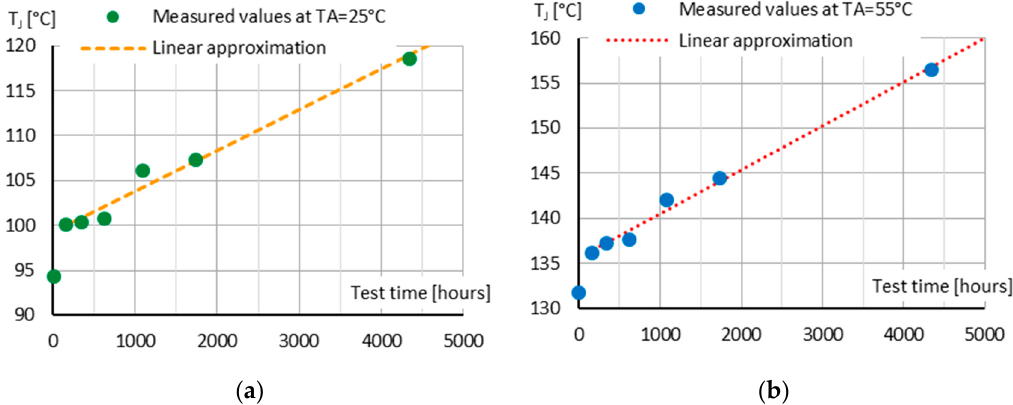
Figure 5. Pn-junction temperatures of the tested mid-power LED (#S11) over the testing time, measured at 300 mA forward current, ( a ) at 25 °C and ( b ) at 55 °C ambient temperatures.